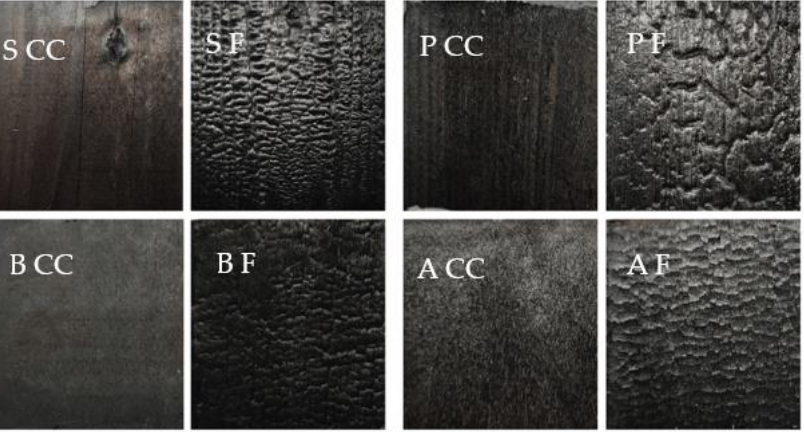
Figure 1. Contact-charred (CC) and flame-charred (F) spruce (S), pine (P), birch (B), and aspen (A). The boards were cut to 100 mm × 50 mm (tangential × radial) for sorption experi- ments, excluding parts with uneven charring result (rounded edges, inadequate